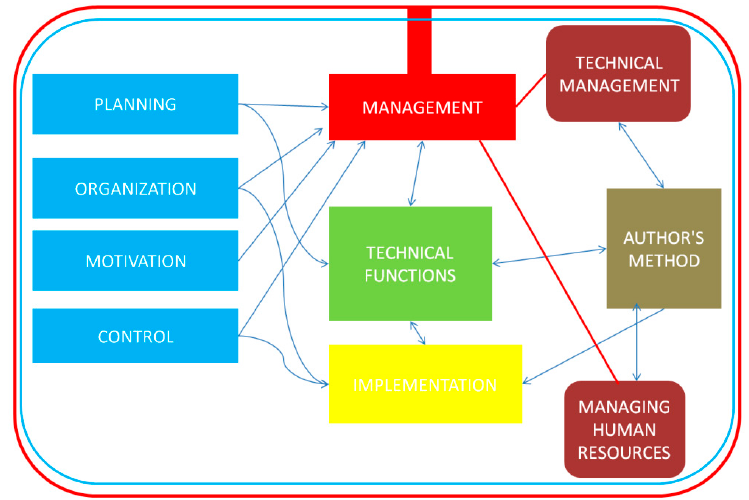
Figure 2. Management implementation model in combination with technical functions. Source: authors’ visualization of their solution (method) among aspects of management (based on Hashiba and Chang, 1992).